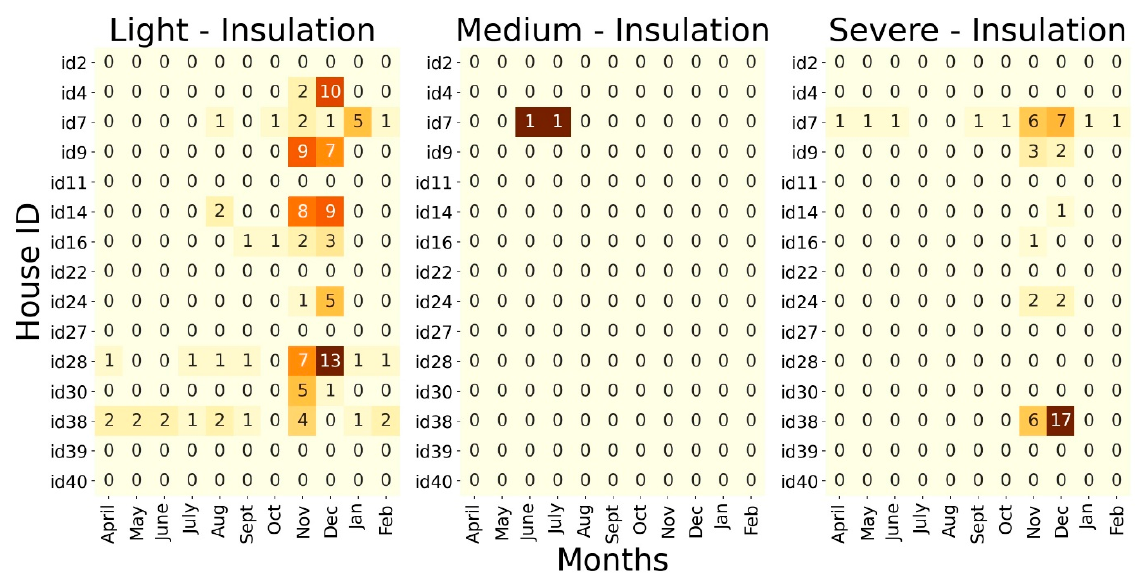
Figure A8. Results of the underheating criteria 2 applied to the models with only insulation. The X axis shows the months, and Y axis shows the house ID. The intersection of both shows the number of underheated light (left), medium (middle), and severe (right) days in that month.